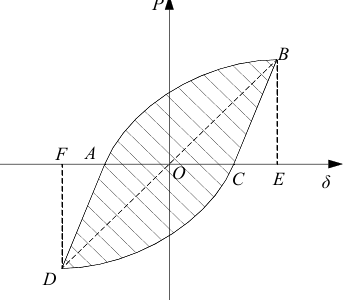
where ξ eq is the equivalent viscous damping ratio, S (ABC+ADC) is the area enclosed by the hysteretic loop, and S ( Δ OBE+ Δ ODF) is the sum of areas of triangles OBE and ODF.